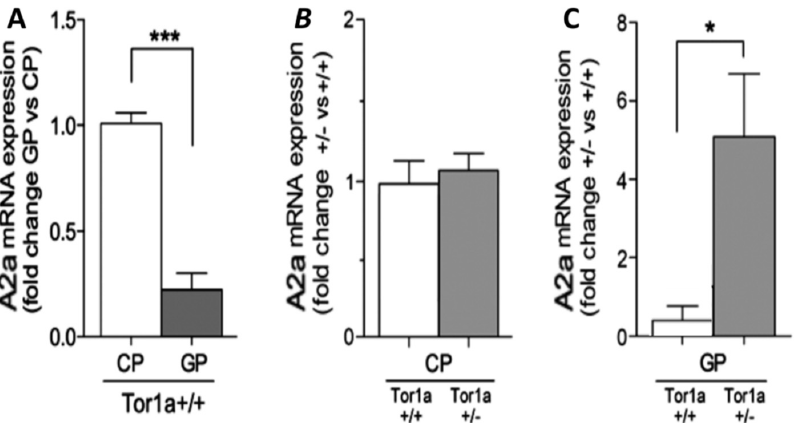
Figure 3. ( A )—Comparative real-time PCR of A2A mRNA in caudate–putamen (CP) and globus pallidus (GP) of Tor1a+/+ control mice ( n = 6, df = 1, F = 71.172, p = 0.001). ( B )—The expression of A2A mRNA in the CP of Tor1a+/+ mice is compared to the levels in the CP of Tor1a+/ − mice ( n = 8, df = 1, F = 0.311, p = 0.586). ( C )—The expression of A2A mRNA in the GP of Tor1a+/+ mice is compared to the levels in the GP of Tor1a+/ − mice ( n = 7, df = 1, F = 4.743, p = 0.048). Results were expressed as the mean ± SD of values obtained from each group. Data in ( A – C ) were analyzed with one-way ANOVA followed by Bonferroni’s correction for multiple data. * p < 0.05, *** p <